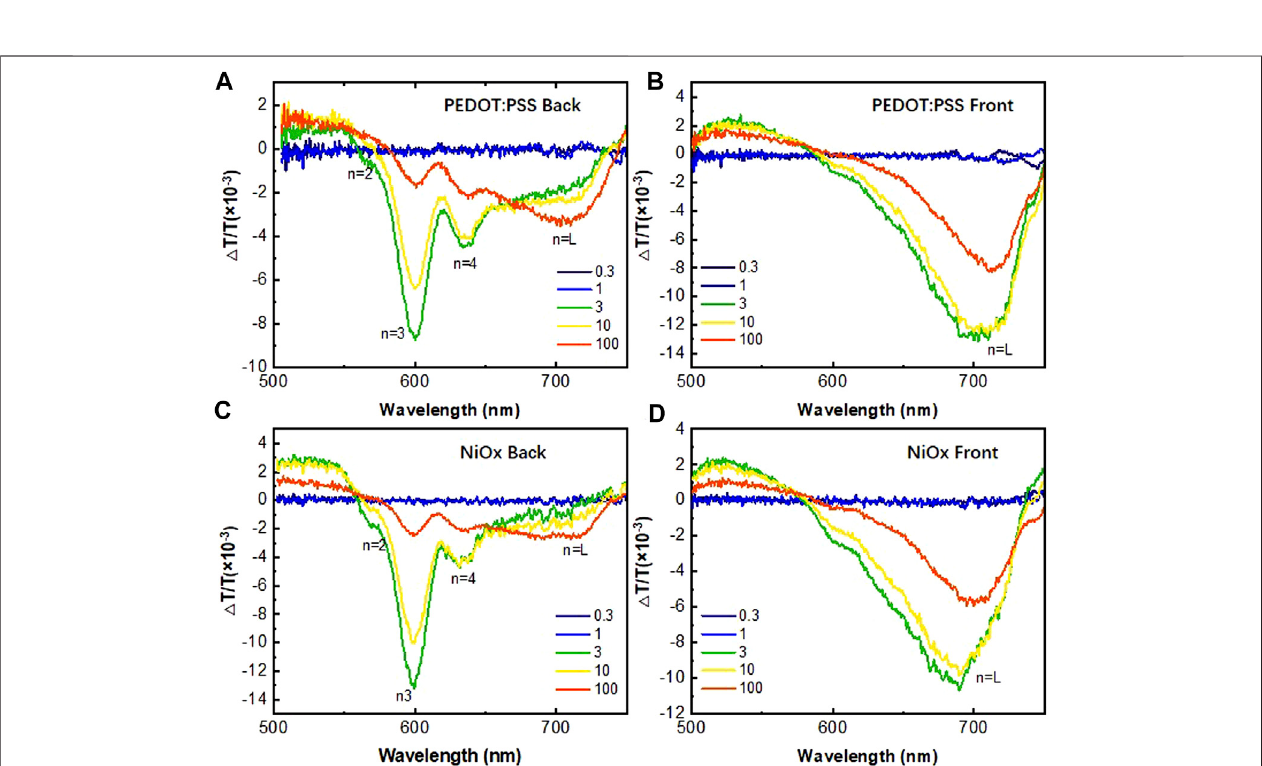
FIGURE 5 | (A) TA spectra of PEDOT:PSS – based samples from back-side excitation and (B) front-side excitation. (C) TA spectra of NiO x -based samples from back-side excitation and (D) front-side excitation.